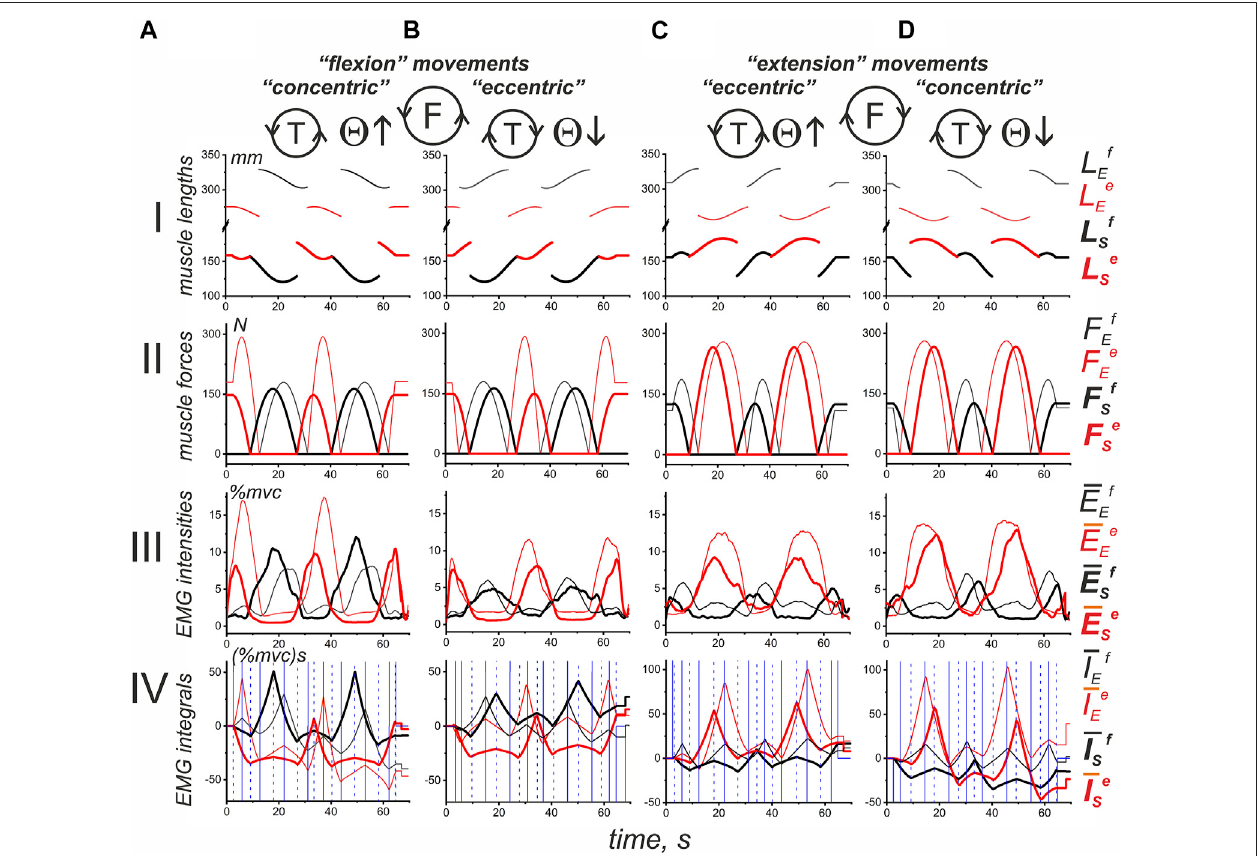
FIGURE 8 | Average of the results obtained in identical experiments with four different subjects. The records of muscle length (I) and force (II) were taken from an experiment with subject YK, of which a complete anthropometric identi fi cation of his right arm was obtained (see Methods). First, for each subject, including YK, the averageEMGrecordingsbelongingtothefollowingfourmusclegroupswereobtained: (A) elbow fl exors (anadditionalaveragingprocedurewasappliedtotherecordsof BrRad, BicBr, BicLg ); (B) elbow extensors ( TrBr, TrLat ); (C) shoulder fl exors ( Pect, DeltCl ); and (D) shoulder extensors ( DeltSc ). Second, using the corresponding Sw functions reconstructed for the muscles of subject YK, the EMG integrals (as shown in Figure 7 ) were determined for each subject. Third, the corresponding EMG integrals, which were previously determined for different subjects, were averaged within each of the muscle groups, and the resulting records are presented in line IV. In addition,lineIIIshowstheresultsofthein-groupaveragingofthecorrespondingEMGsofthefoursubjects.Thedatarelatedto fl exorandextensormusclesareshownin black and red, where the thin and thick lines represent the muscles of the elbow and shoulder joints, respectively. The blue vertical lines in line IV correspond to the ascending and descending portions of the Sw functions de fi ned for the muscles of the elbow (solid lines) and shoulder (dashed lines) joints.